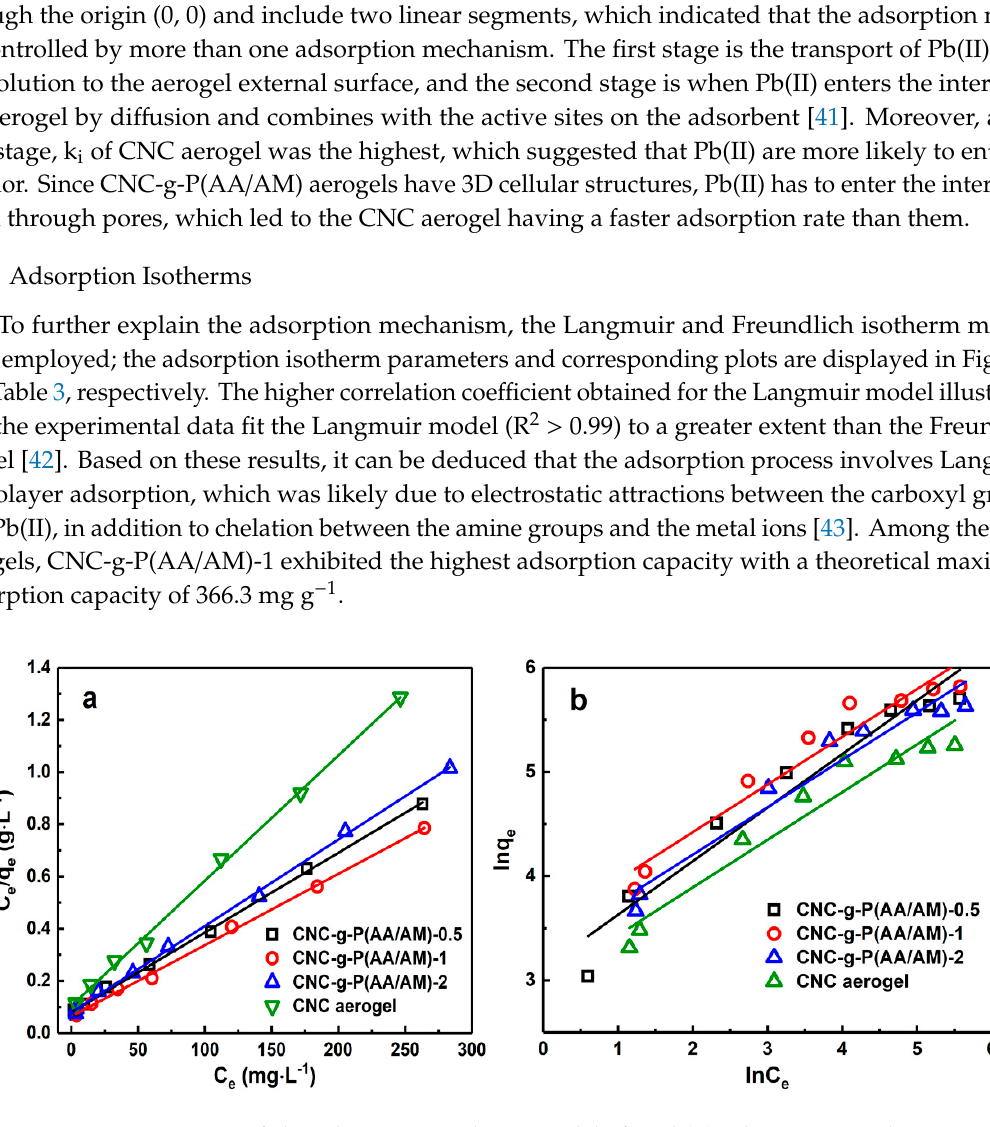
Table 2. Kinetic parameters of the intra-particle diffusion model.